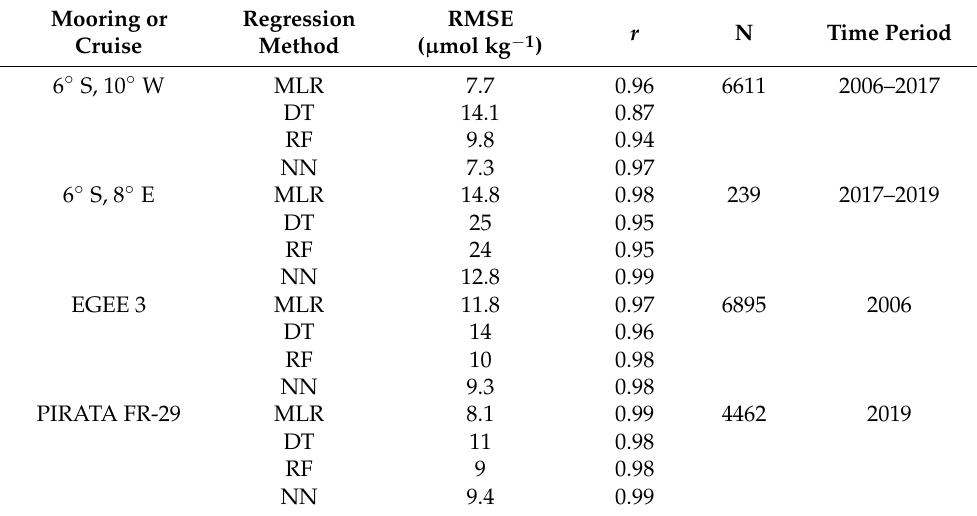
Table A4. Same as Table 2, but including a comparison between the multiple linear regression (MLR), the decision tree (DT), the random forest (RF) and the feed forward neural networks (NN)